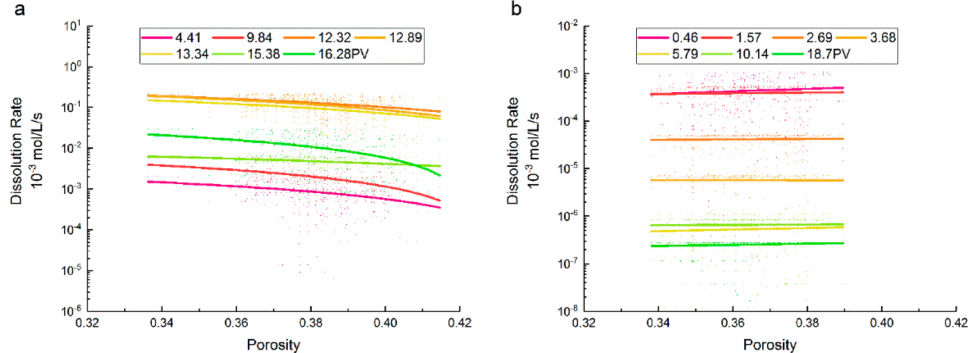
Figure 4. CO 2 dissolution rate vs. porosity at different injection PVs for ( a ) supercritical CO 2 and ( b ) gaseous CO 2